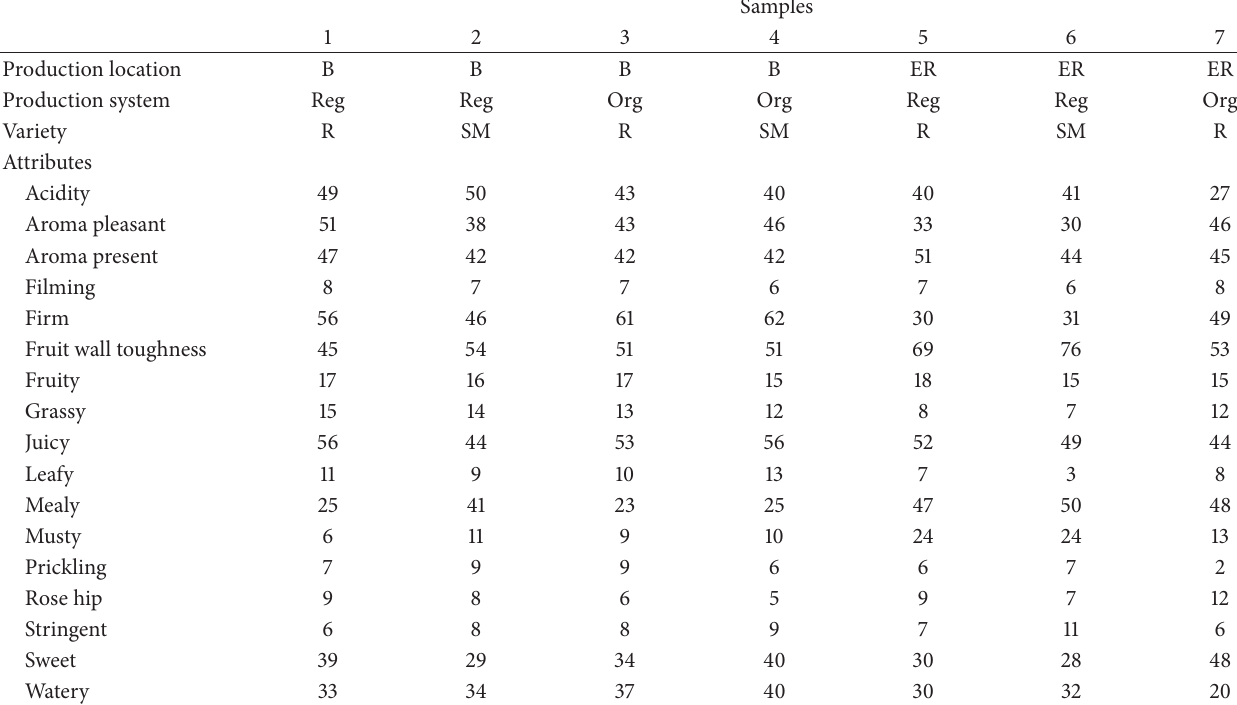
Table 1: Results of sensory analysis of the 2012 tomato samples a .